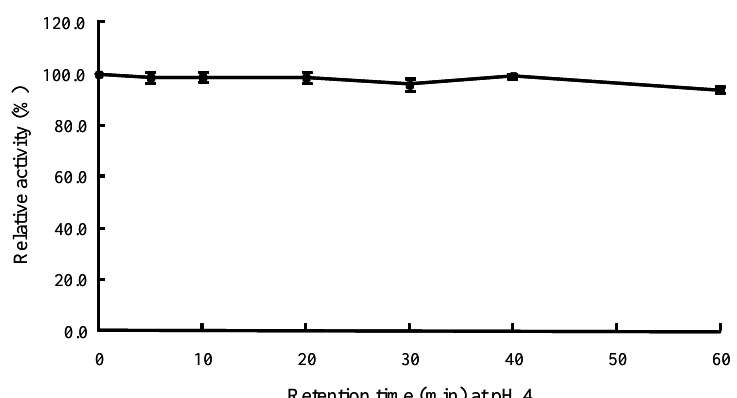
Figure 5. The stability of the LX-20  -galactosidase at pH 4 during immobilization process. Data were expressed as mean and standard errors from three experiments.